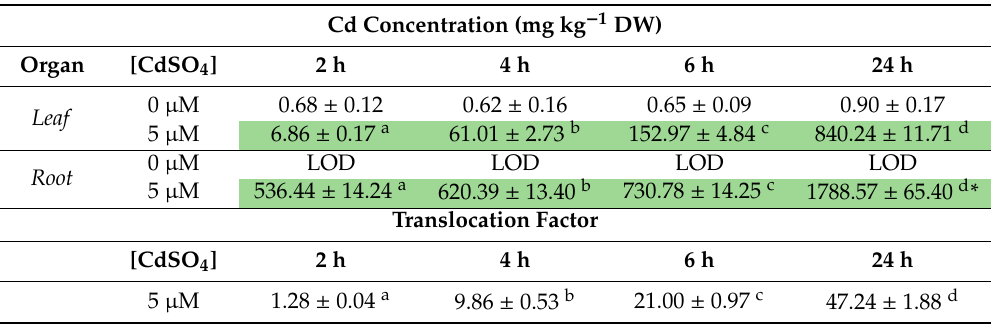
Table 1. Cadmium concentrations (mg kg − 1 dry weight) in leaves and roots and the translocation factor (%) of Arabidopsis thaliana plants grown under control conditions (0 µ M CdSO 4 ) or exposed to 5 µ M CdSO 4 during 2 h, 4 h, 6 h, 24 h after 3 weeks of growth. For each time point, data represent the mean ± S.E. of four biological independent replicates. Significant di ff erences ( t -test: p < 0.05) between control and exposed plants, within each time point, are marked in green. Significant di ff erences over time are indicated with di ff erent letters (one-way ANOVA: p < 0.05). LOD: Cd levels below limit of detection